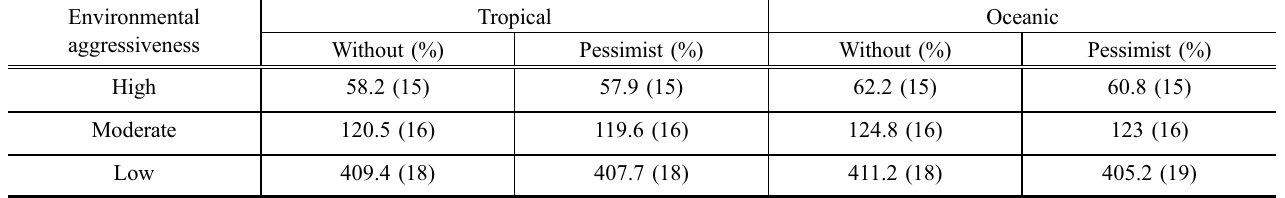
Table 7 Mean (in years) and coefficient of variation (between brackets) of the total lifetime without fatigue effects. Environmental